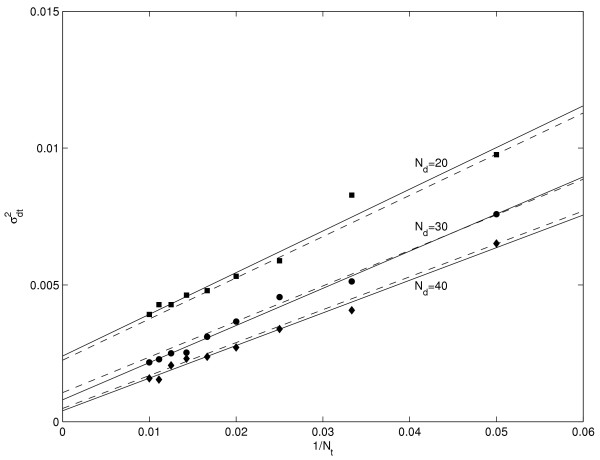
Least squares fitting for different sizes of Nd. The variance σdt2 plotted against 1/Nt, where Nt is the number of test (holdout) samples used. The solid lines are the least squares fittings of the simulated average values for 1/Nt. The dashed lines are produced by means of the analytical result in Eq. (2).